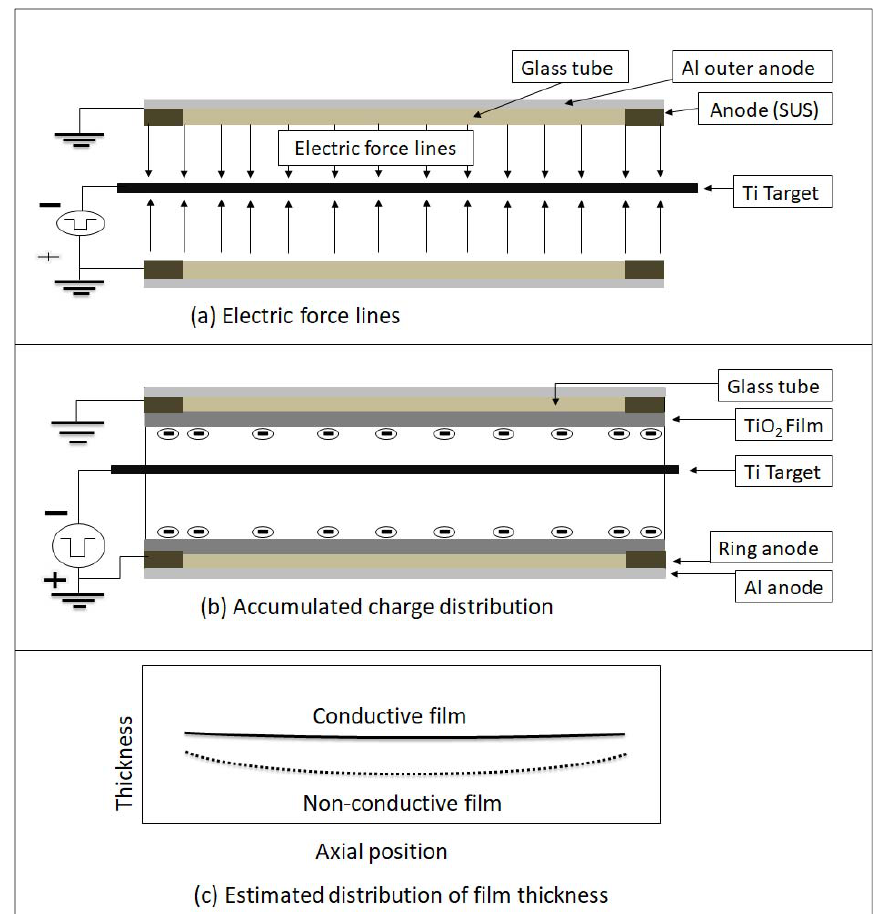
Figure 11. Schematic representation of the electric force lines, electric charges distribution, and estimation of the film thickness distribution in the case with the Al outer anode. ( a ) A schematic representation of the electric force lines around the glass tube; ( b ) accumulated charge distribution around the glass tube; and ( c ) an estimation of the film thickness distribution in the case of a high resistance film.